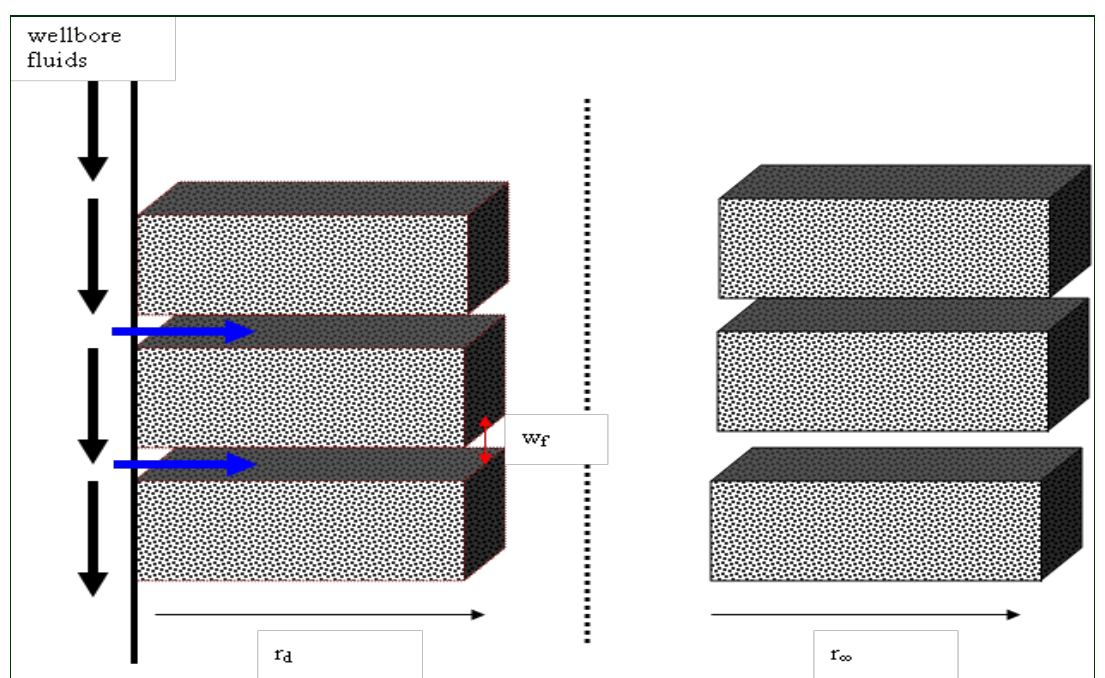
Figure 1. One-half of wellbore area in a fractured reservoir during drilling operation (modified after